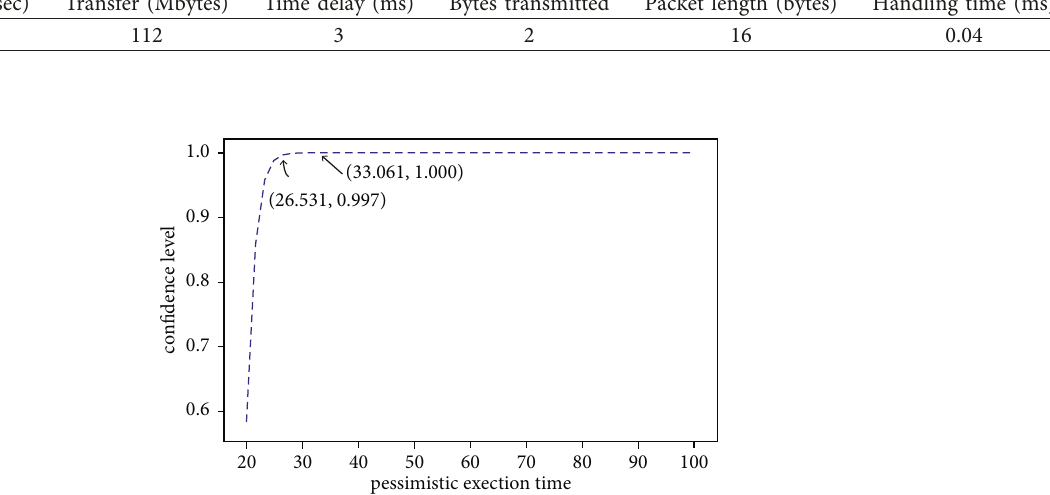
Figure 6: The confidence level against the pessimistic transmission time estimate.